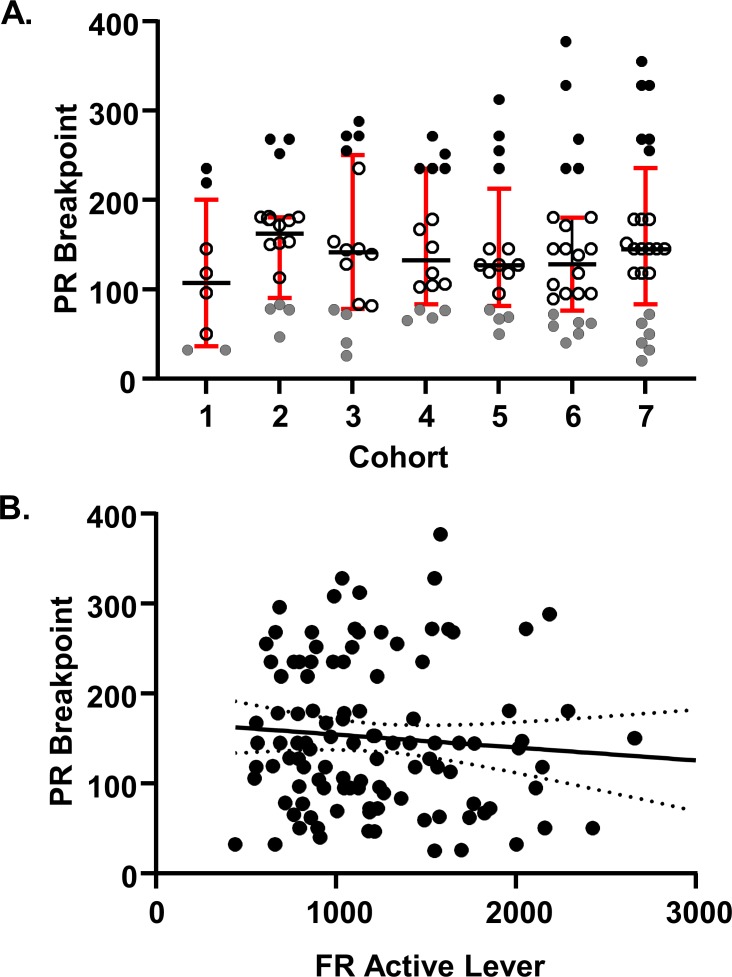
Cohort to cohort variability and FR-PR correlation.(A) Seven cohorts of rats were used in the study. Cohort size was 8, 16 or 24 subjects. For each cohort, the highS group was identified as the top quartile of the interquartile distribution and lowS as the bottom quartile of the interquartile distribution. Animals for individual experiments were drawn from these cohorts as follows: Corticosterone assay: cohort 5; RNA-seq: cohort 5; Electrophysiology: cohorts 1–6; UK-78,282 microinjections: cohort 7. Note that across cohorts, behavioral performance of every lowS animal was dramatically different from behavior of every highS animal. Note also that across cohorts, there was some overlap in breakpoint values between midS and highS values (e.g. highS in cohort one and midS in cohort 3) as well as midS and lowS values (e.g. lowS in cohort two and midS in cohort 3). (B) There was no correlation between FR active lever presses on FR10 and PR breakpoint (Pearson’s r2 = −0.089, p=0.35).